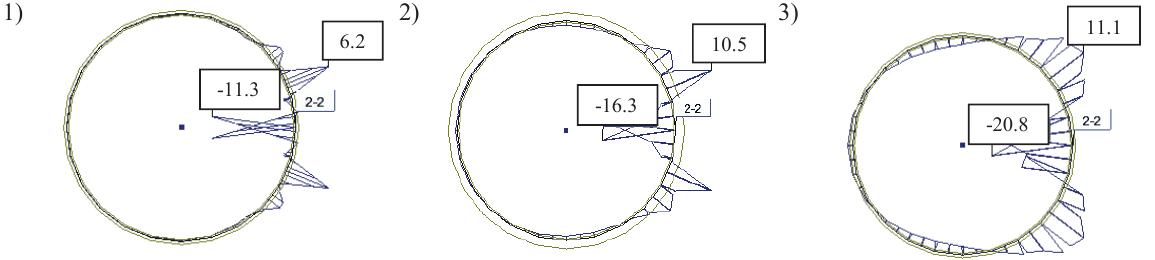
hz Figure 7. Diagrams of hoop moments, M c